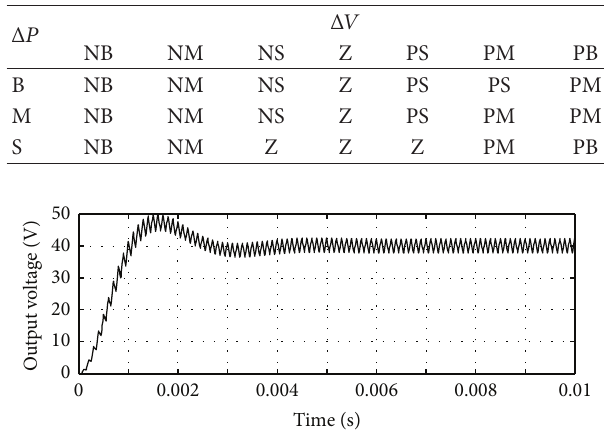
Table 3: Maximum power point tracking fuzzy rule base.